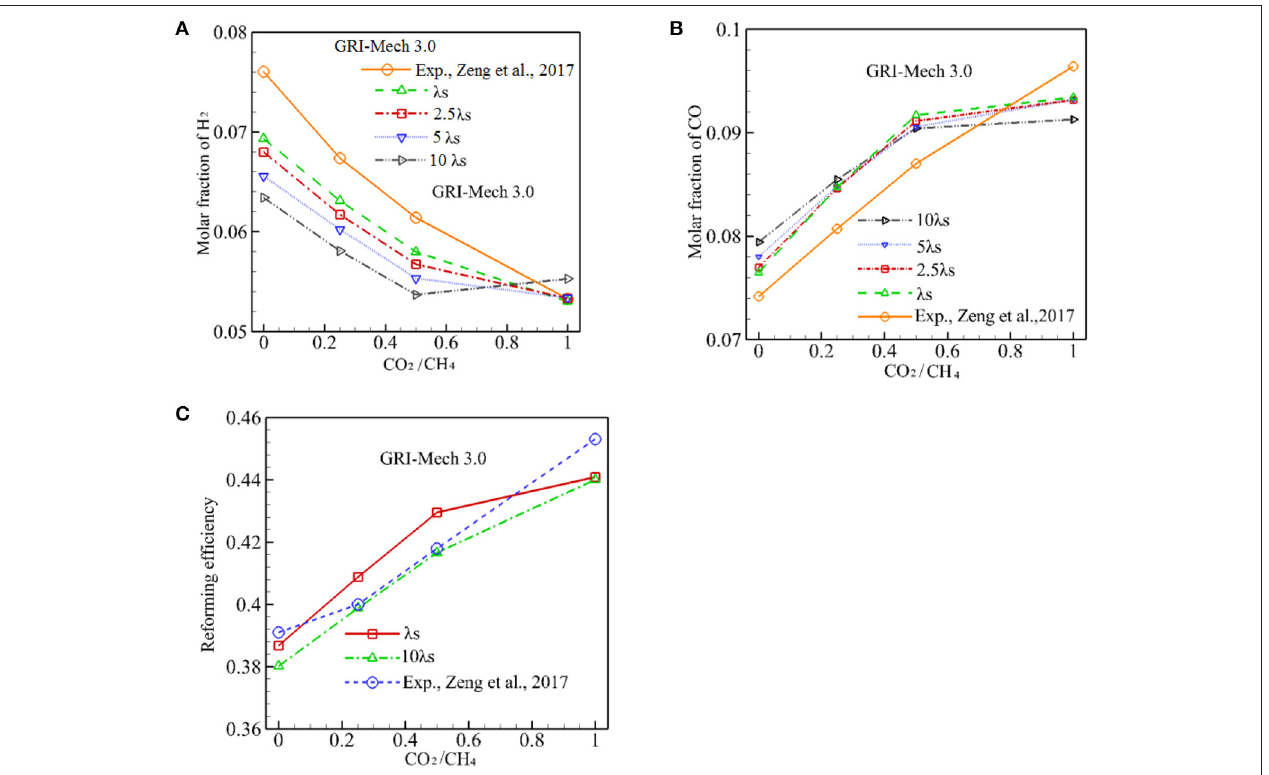
FIGURE 6 | Effect of packing bed thermal conductivity on molar fraction of CO, H 2 , and conversion efficiency with GRI-Mech 3.0. (A) Molar fraction of H 2 ; (B) Molar fraction of CO; (C) Reforming